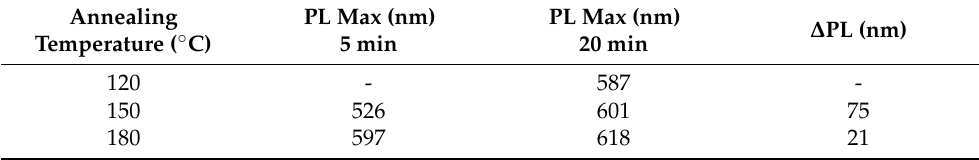
Table 1. Photoluminescent (PL) peak position as a function of annealing time and